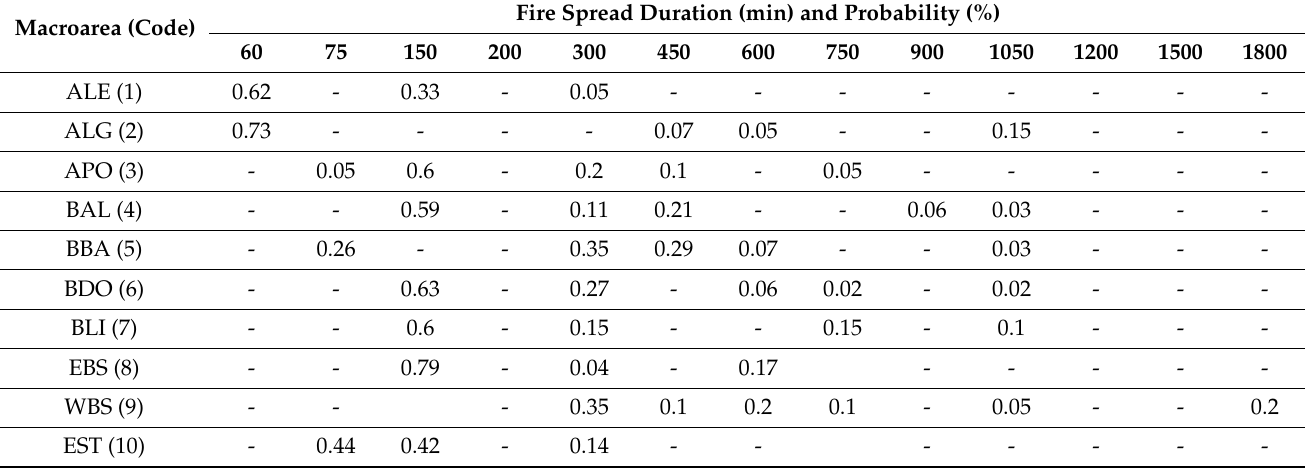
Table A3. The fire spread modeling duration probabilities by macro-area replicating historic large fire size (>100